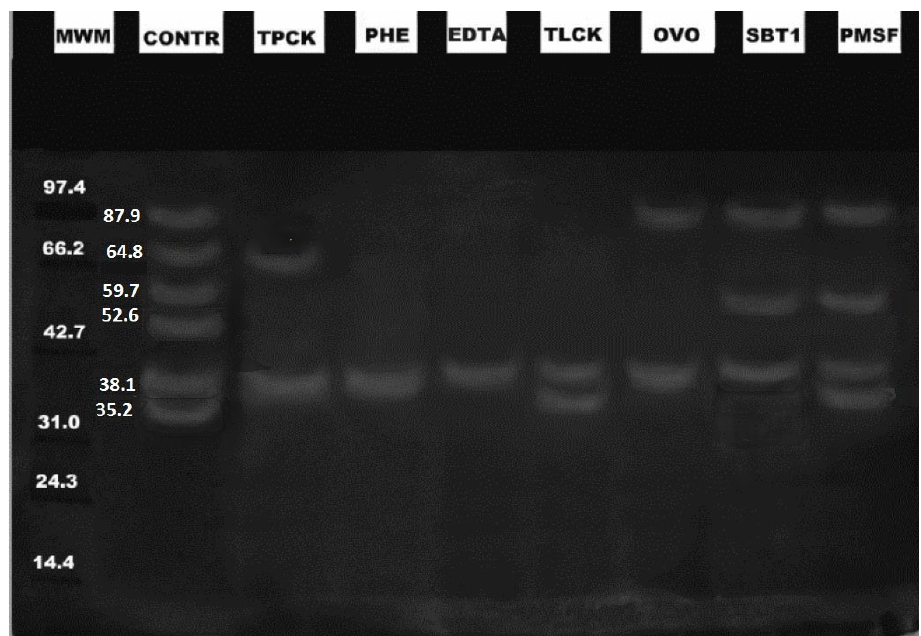
FIGURE 4 | SDS-PAGE zymogram of alkaline digestive proteases of short-tailed pipefish ( Microphis brachyurus ) juveniles: Molecular weight marker (MWM), rabbit phosphorylase B (97.4 kDa), bovine serum albumin (66.2 kDa), ovalbumin (42.7 kDa), carbon anhydrase (31.0 kDa) and lysozyme (14.4 kDa); control (without inhibitor); inhibitors were the same as in Fig.